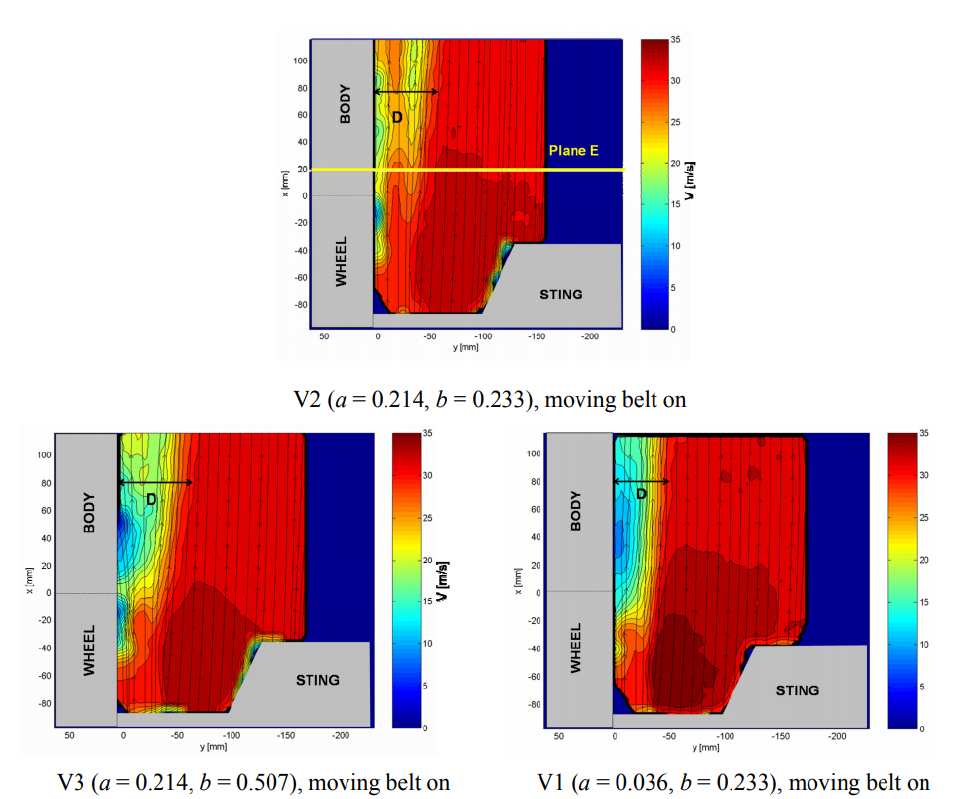
Figure 7. Top view horizontal plane: velocity contours and streamlines in configuration of volumes V1, V2, and V3 with the rotating wheel by Cazat and Gilliéron